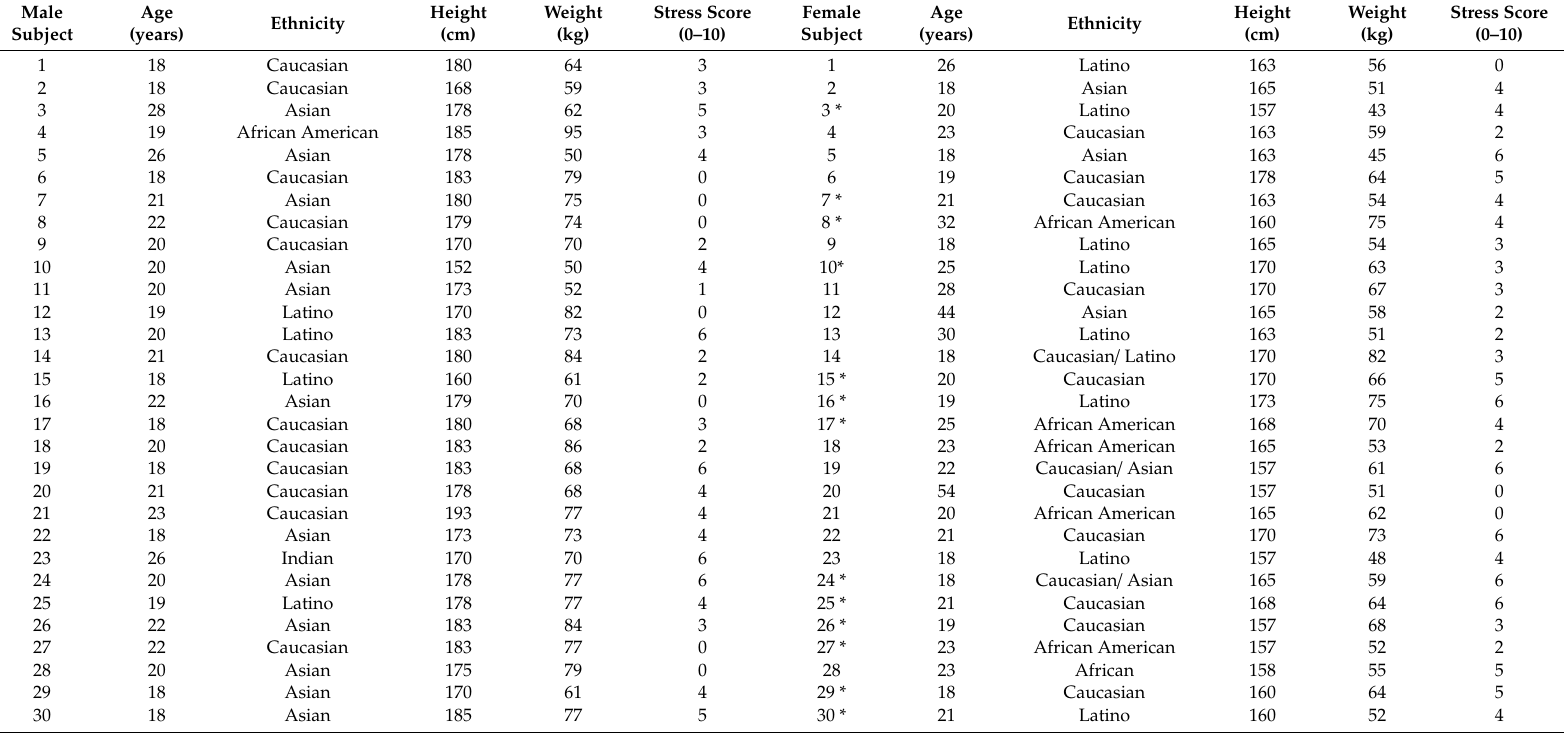
Table 3. Demographics of healthy subjects. Included are subject age, ethnicity, height, weight, and qualitative stress score (at the time of subject consent). Women taking birth control are denoted with